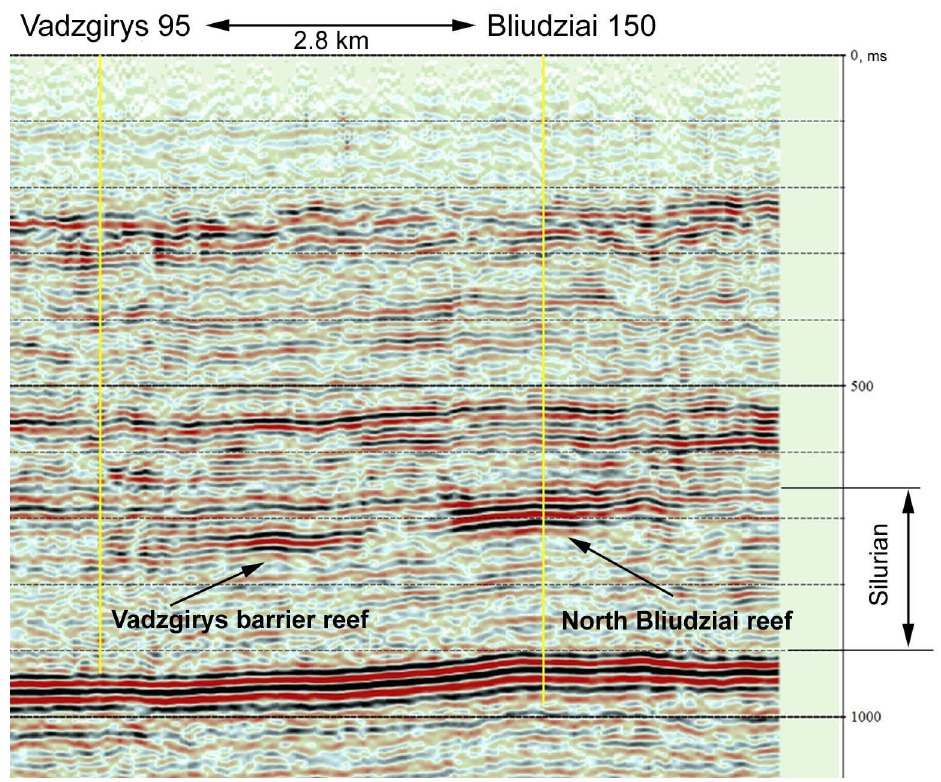
Fig. 8. Three-dimensional seismic cross line. See RMS attribute maps for its